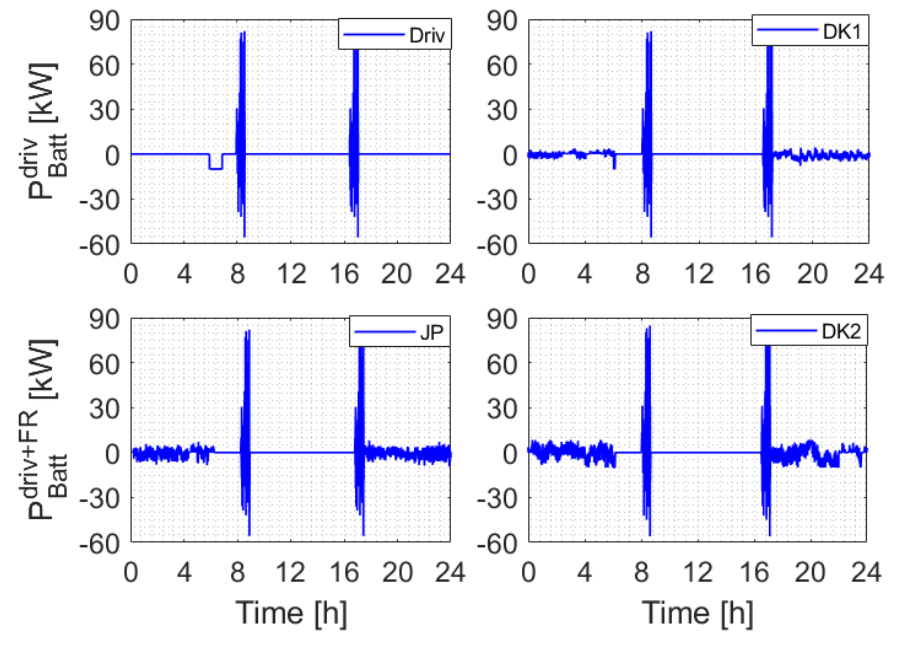
Figure 6. Battery power of the three scenarios during one-day period: driving, driving + FR in DK1, DK2 and JP.